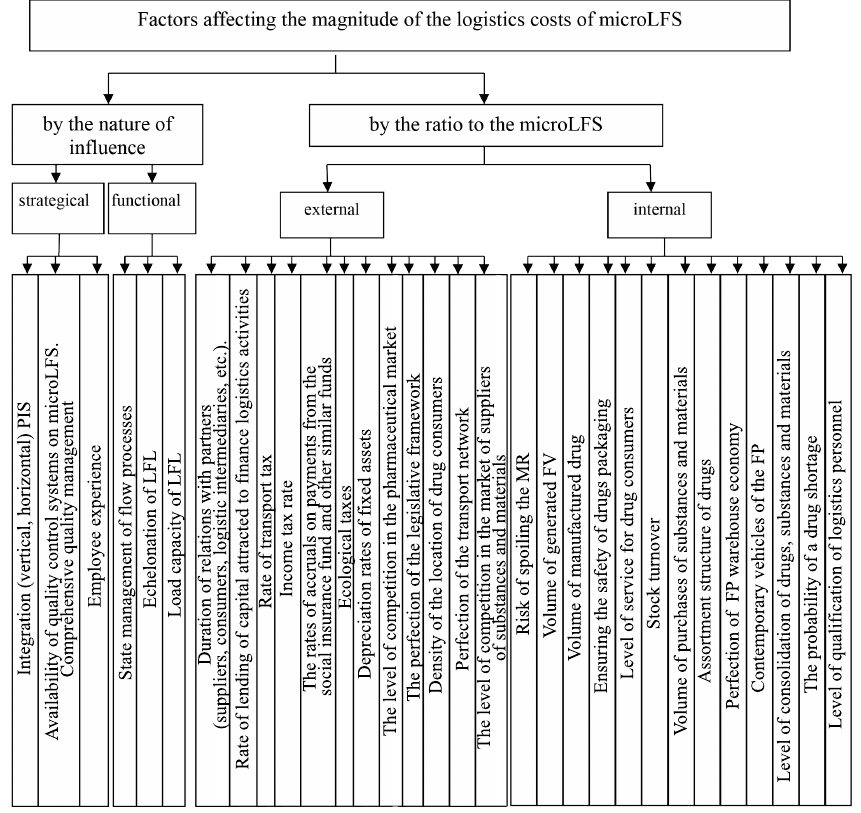
Fig. 2. Classification of factors of influence on the magnitude of the logistics costs of